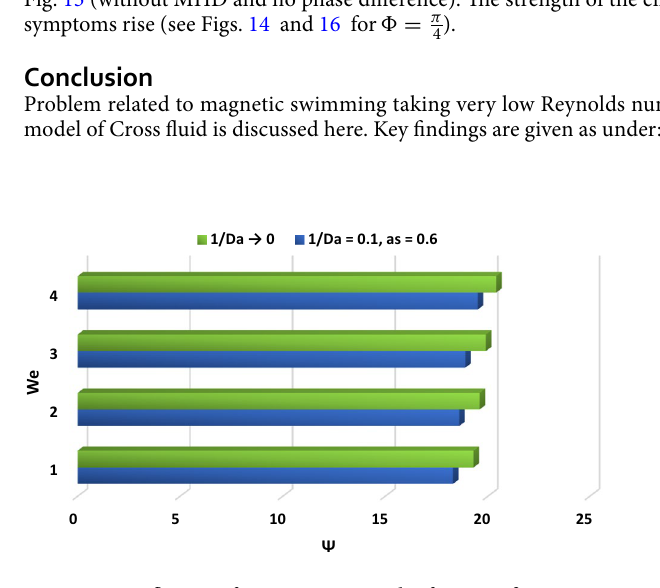
Figure 12. Influence of We on ψ as a result of a magnification in